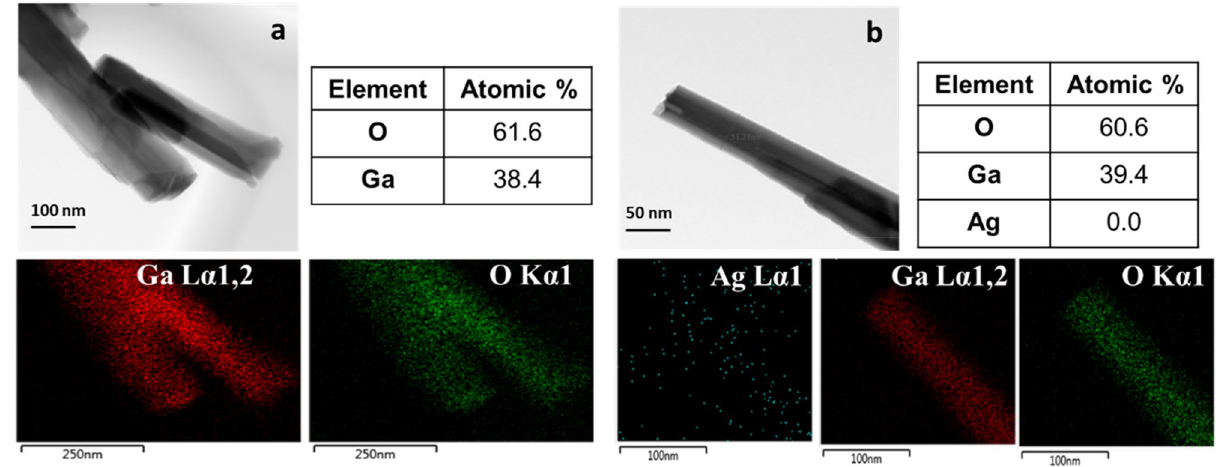
Figure 8. HRTEM image and the corresponding EDS mapping of Ga 2 O 3 NW grown on quartz substrates (left) without the presence (right) in the presence of Ag